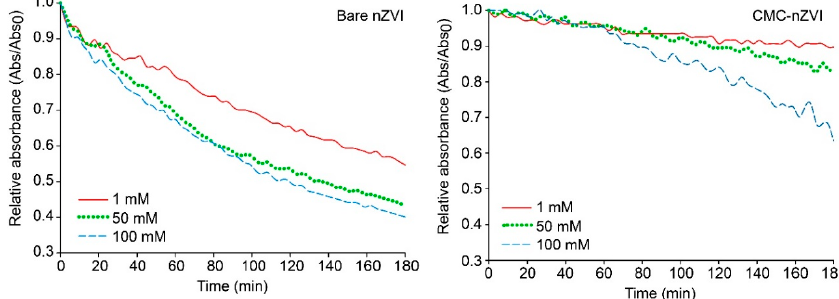
Figure 7. Effect of CMC polymer stabilizer and IS on the stability of 0.1 g L − 1 nZVI particle suspensions at pH 9.